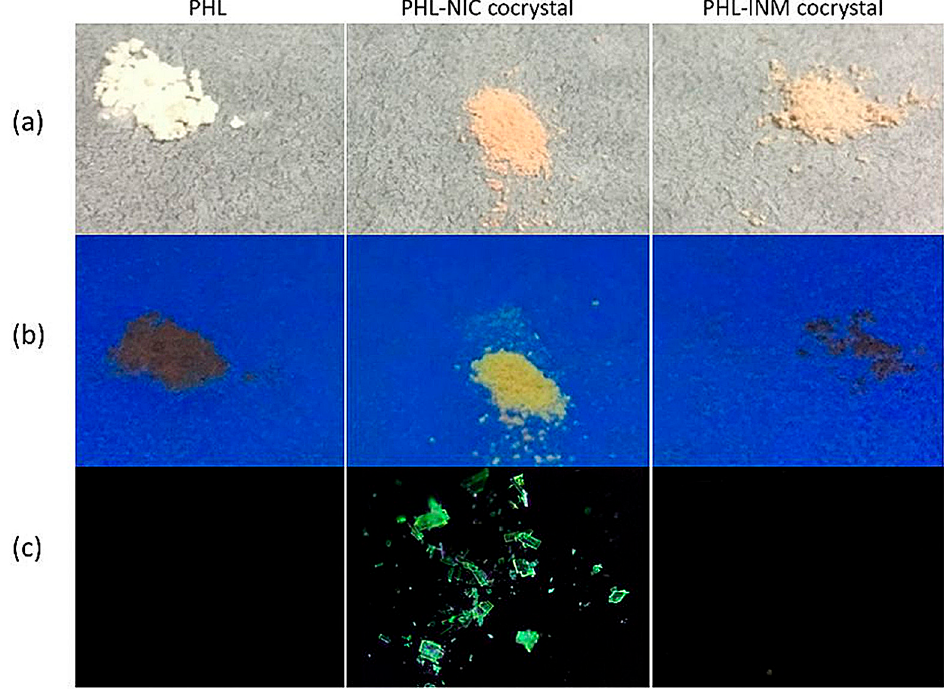
Figure 15. Photographs of solid-state cocrystal samples (from left to right: PHL, PHL-NIC cocrystal and PHL-INM cocrystal): ( a ) the powder samples under daylight; ( b ) the powder samples under UV (365 nm) lamp; ( c ) the single crystal samples under UV (365 nm) observed by polarized microscope. Adapted from [79] with permission. Copyright © 2019 American Chemical Society.